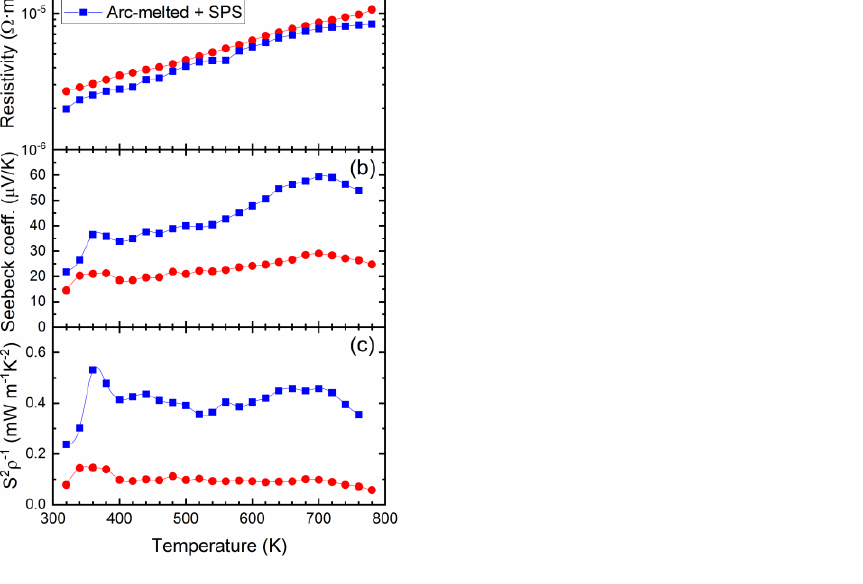
Figure 7. Temperature dependence of the three main thermoelectric properties: ( a ) resistivity, ( b ) Seebeck coefficient, and ( c ) power factor.